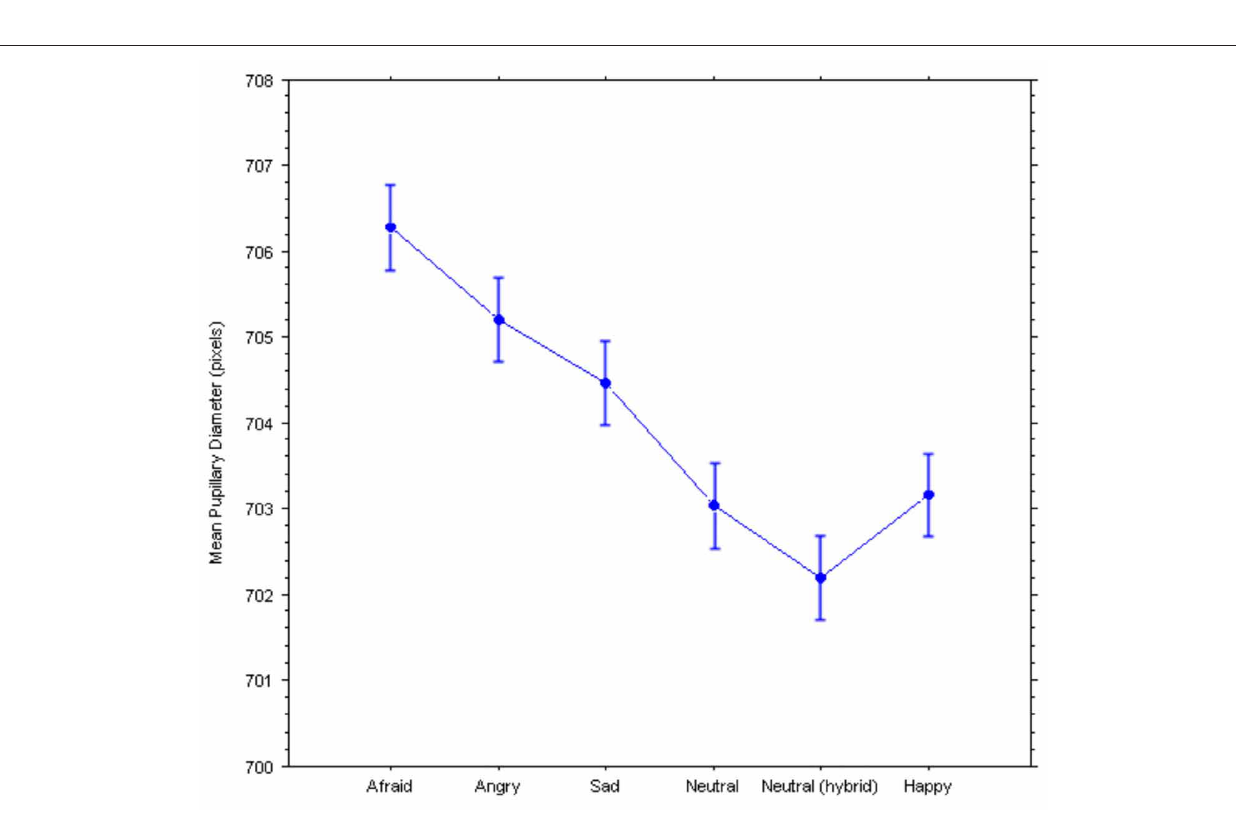
Frontiers in Psychology | Cognition May 2013 | Volume 4 | Article 291 |